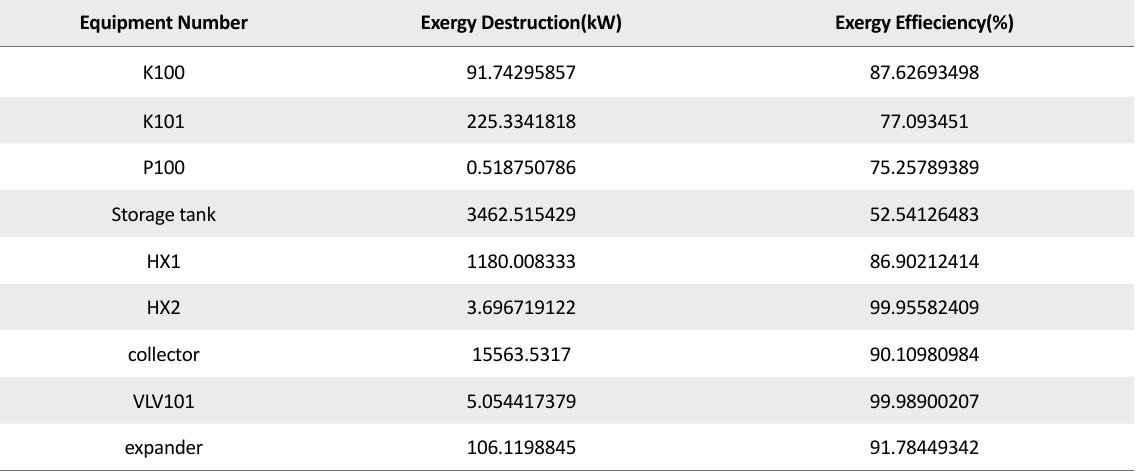
Table 7. Exergy results of the main equipment of the hot water production system of Ahvaz Pipeline Co.